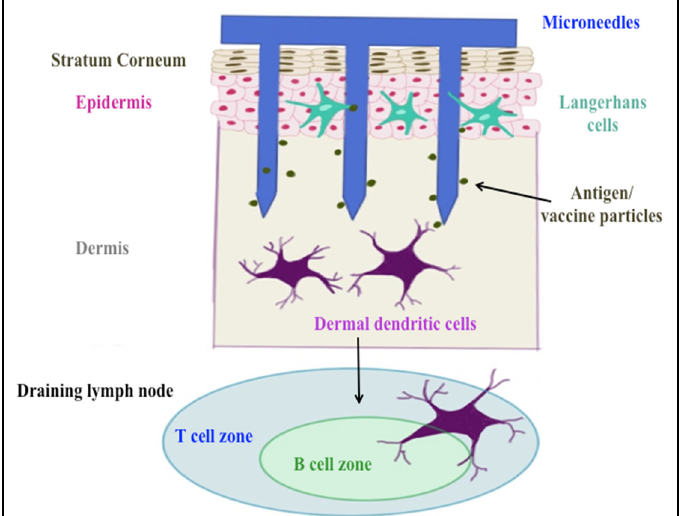
Figure 1. Skin layers and microneedle immunization targets.